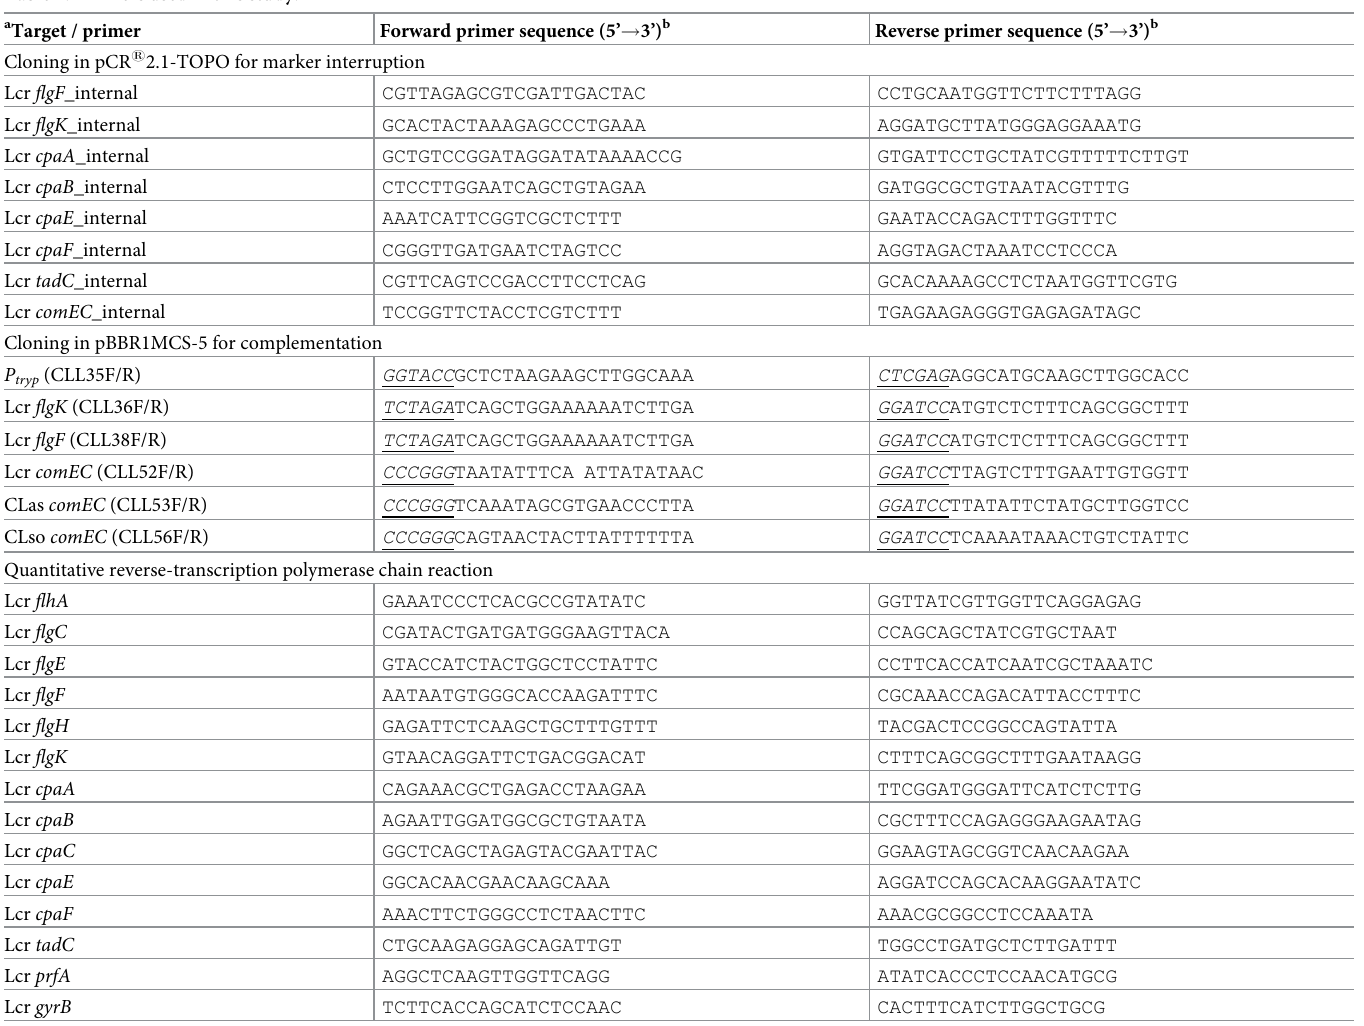
Table 2. Primers used in this